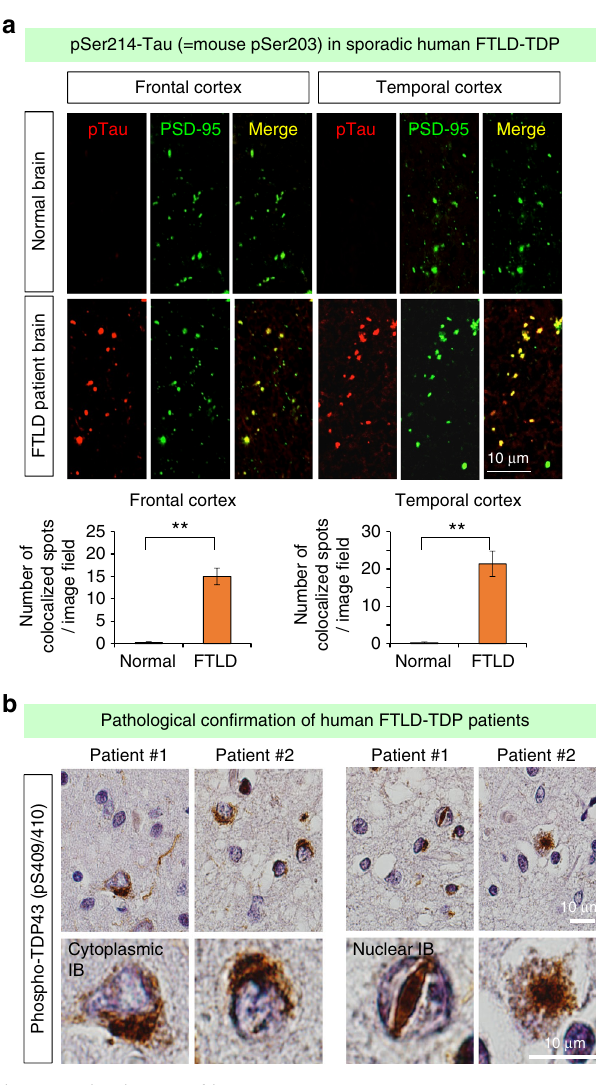
Fig. 10 Mislocalization of human pSer214 to spine. a Immunohistochemistry of pSer214-tau, which corresponds to mouse pSer203-tau, in human sporadic FTLD-TDP autopsy samples revealed similar mislocalization of speci fi c types of tau to PSD95-positive spines (left images). Averages and s.e.m. are shown. Five independent cases were examined, and the averaged values of 10 visual fi elds (40 × 40 μ m) in each case were used for quantitative analysis (right graphs). P -values were determined by Student ’ s t -test ( N = 5). ** p < 0.01. b Pathological diagnosis of patients was based on the presence of TDP43. Findings from each case are shown. p -values are shown in Supplementary data